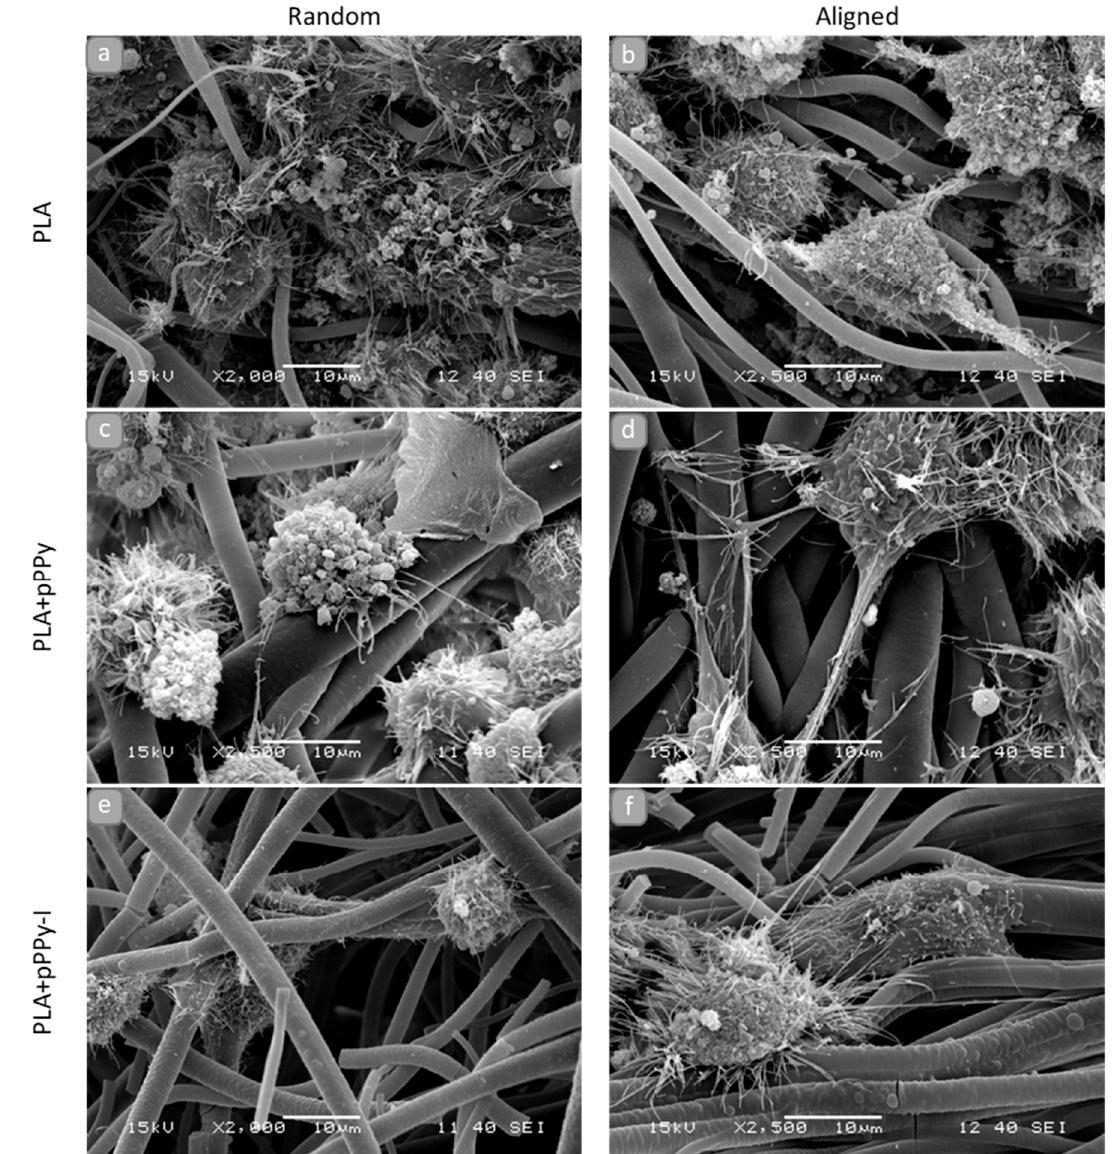
Figure 12. SEM images of NG108 ‐ 15 cells after 15 days of culture on the scaffolds, ( a ) rPLA, ( b ) aPLA, ( c ) rPLA+pPPy, ( d ) aPLA+pPPy, ( e ) rPLA+pPPy/I, ( f ) aPLA+pPPy/I. Bar = 10 μ m.